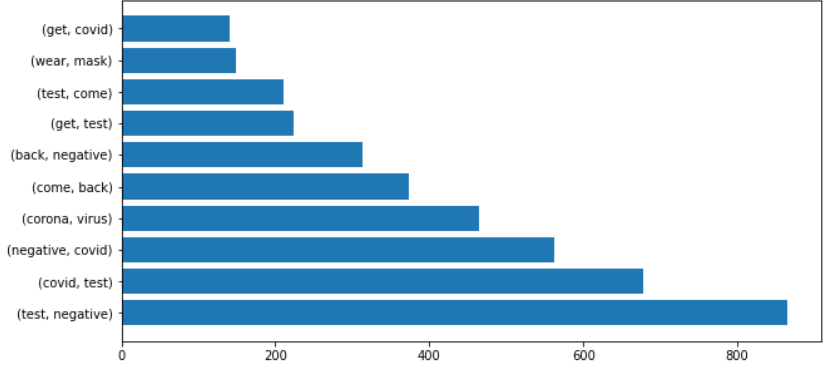
Figure 7. Most frequent bi-grams in the negative